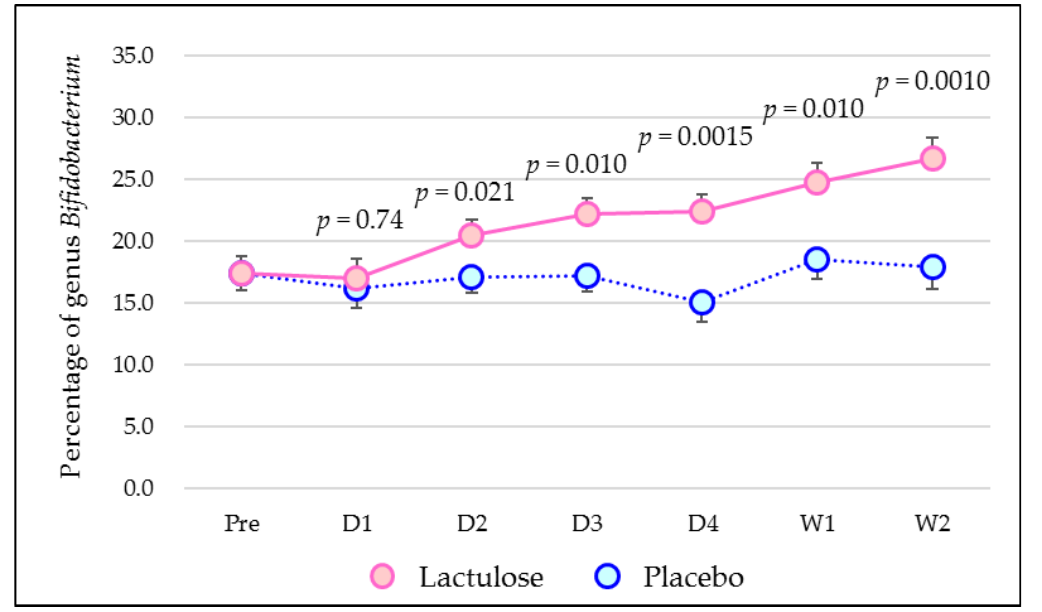
Figure A1. Percentages of genus Bifidobacterium in the faecal microbiome. Pre means just before first ingestion; D1 means 1 day after starting test food ingestion; D2 means 2 days after starting test food ingestion; D3 means 3 days after starting test food ingestion; D4 means 4 days after starting test food ingestion; W1 means 1 week after starting test food ingestion; and W2 means 2 weeks after starting test food ingestion. Values are expressed as the least square mean ± standard error (generalised linear mixed model).